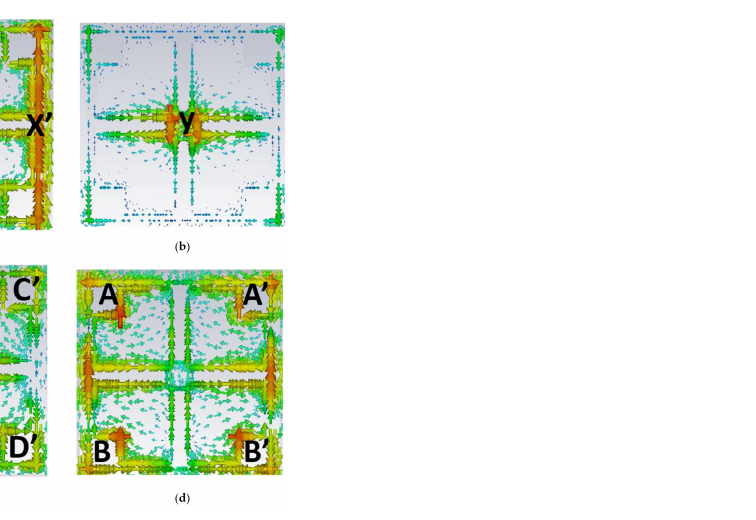
Figure 3. Simulated surface current density for the dual-band MM unit cell at the resonant frequencies ( a ) 0.5 THz, ( b ) 0.9 THz, ( c ) 1.65 THz and ( d ) 2